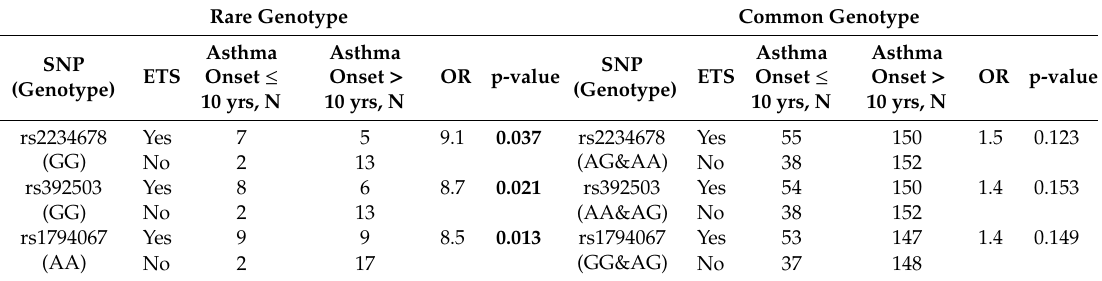
Table 4. Odds ratios of childhood ETS exposure on early onset asthma by SNP genotype